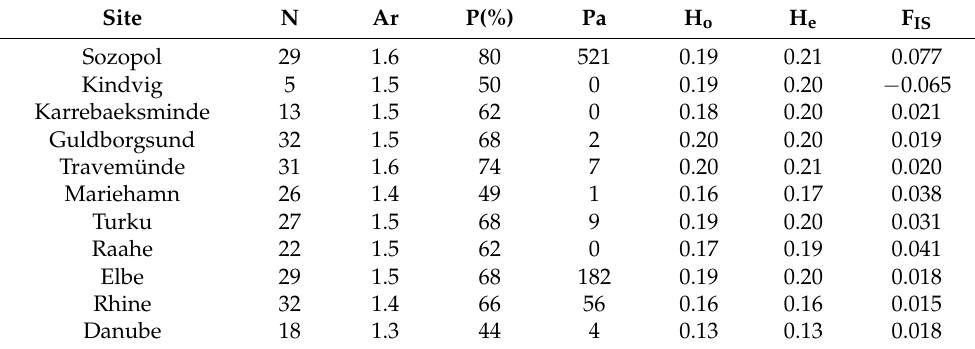
Table 2. Summary statistics of genetic diversity in the round goby ( Neogobius melanostomus ) sampled from two ancestral (Sozopol and the Danube) and nine introduced sites, using 13,847 SNPs. Site N Ar P(%) Pa H o H e F IS